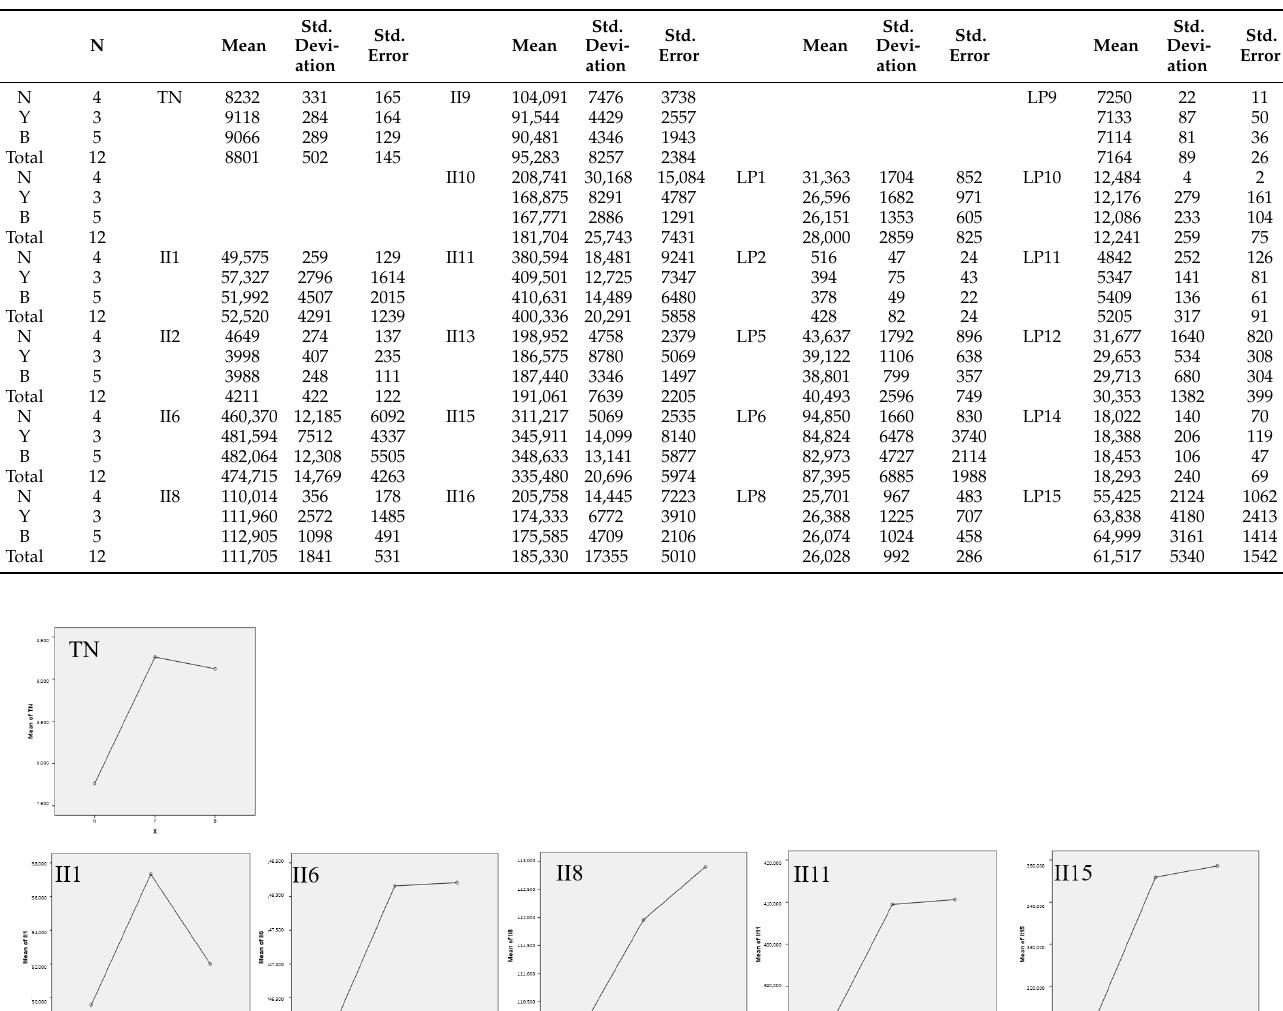
Figure 7. Tourist number of different islands of ST from 2010 to 2018.